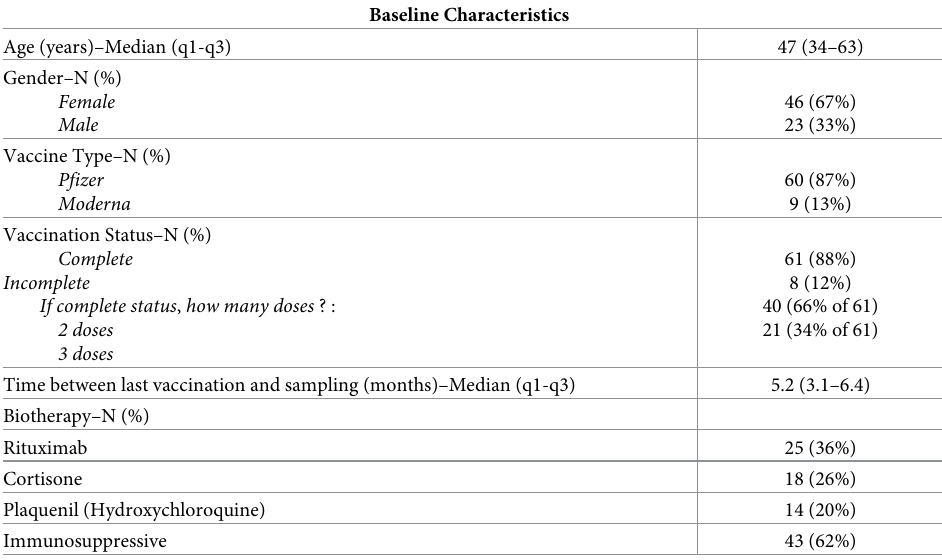
Table 1. Baseline